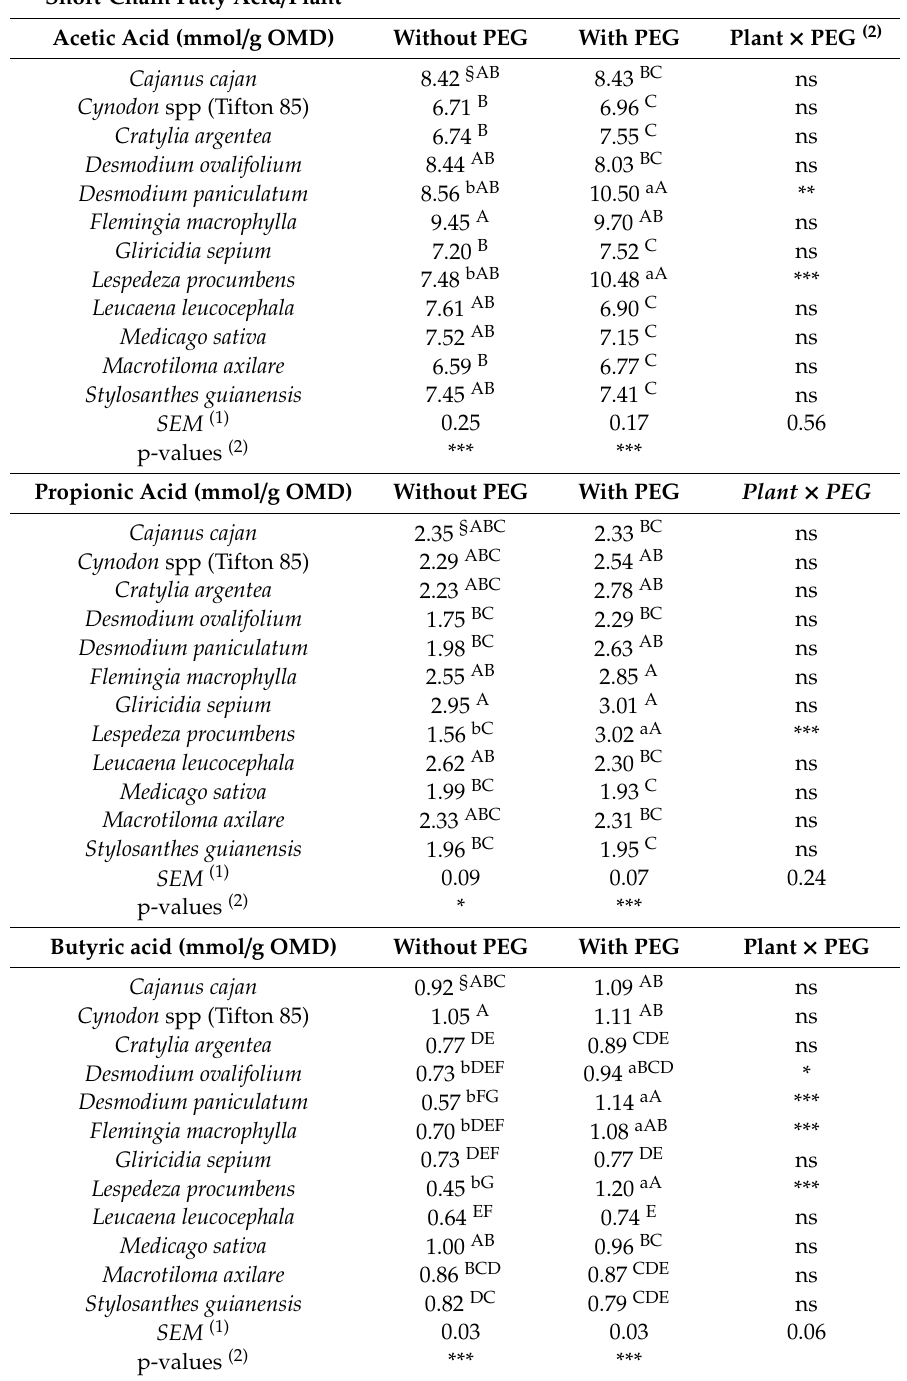
Table 2. E ff ects of tannins from plant species on short-chain fatty acids (concentrations at 96 h of incubation in